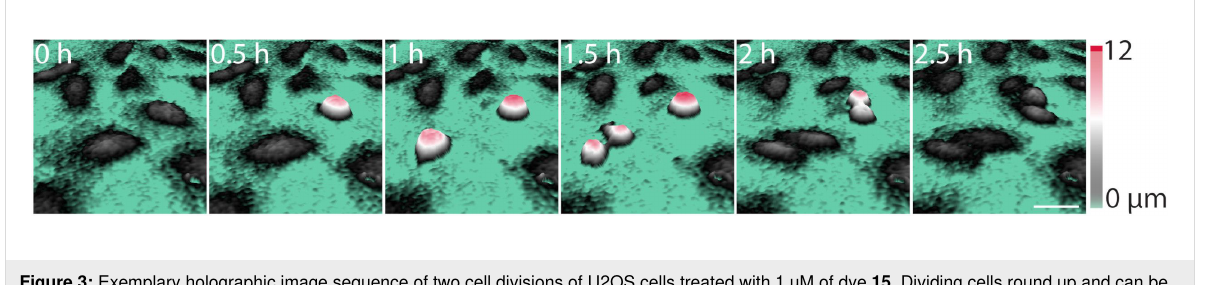
Figure 3: Exemplary holographic image sequence of two cell divisions of U2OS cells treated with 1 µM of dye 15 . Dividing cells round up and can be distinguished from non-dividing cells by height. After incubation with 1 µM dye 15 for 1 h, the cells were washed and then holographically imaged using a HoloMonitor ® M4 time-lapse cytometer. Cell proliferation was followed for 14.5 h (30 min between images) and corresponding time-lapse movies are available in Supporting Information Files 2–5, scale bar 50